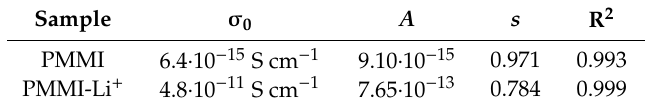
symbols). Table 1. Jonscher’s power law parameters of fit σ (cid:48) curves of PMMI and PMMI-Li + .